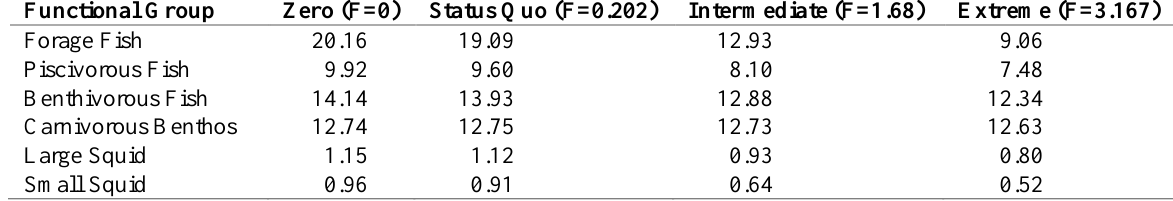
Table A1.3. Forecasted biomasses (g/m 2 ) for the six mid and upper trophic level functional groups at the year 2030 under the four scenarios of commercial forage fish